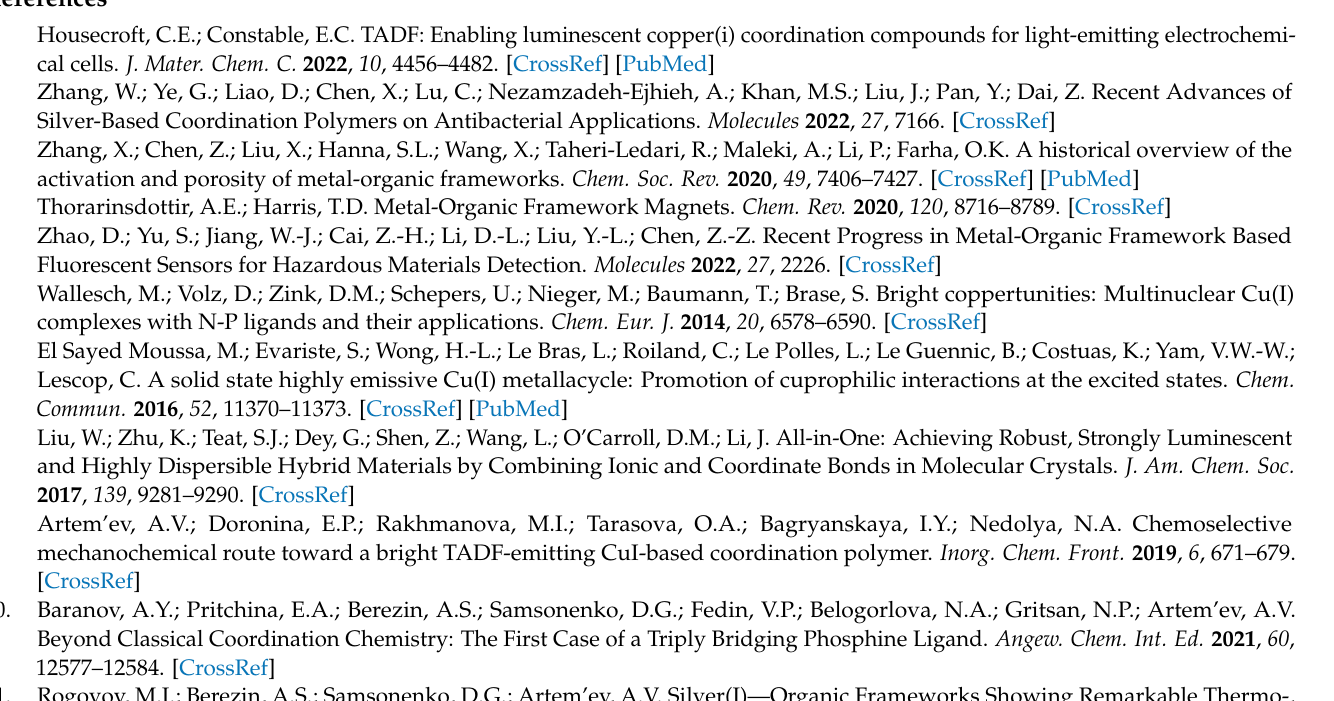
Table S9. Characteristics of S 0 → T x vertical transitions and fragments contributions to the GS and ES electron density for complex 4 .; Table S10. XYZ coordinates of all computes